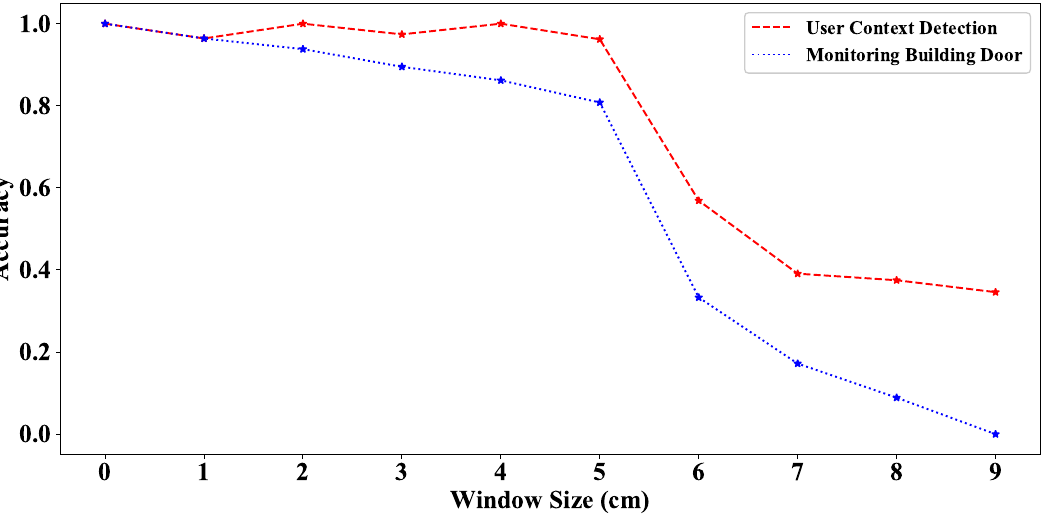
Figure 11. Door detection performance under different opening window